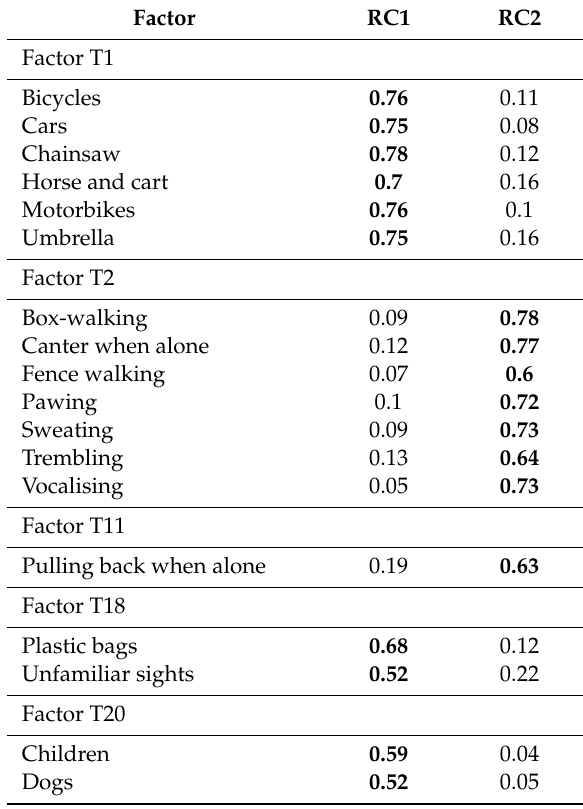
Table 2. Repeated parallel analysis with two T11 questions removed due to substantially lower response rates compared to other E-BARQ items. The number of rotated components was dropped from 3 to 2 from the previous analysis after suggestion to remove these questions. Significant loadings are in